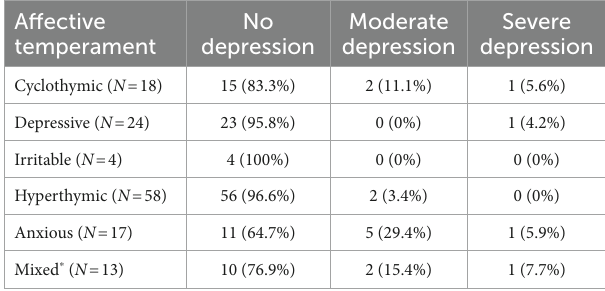
TABLE 2 Affective temperament and depression severity.